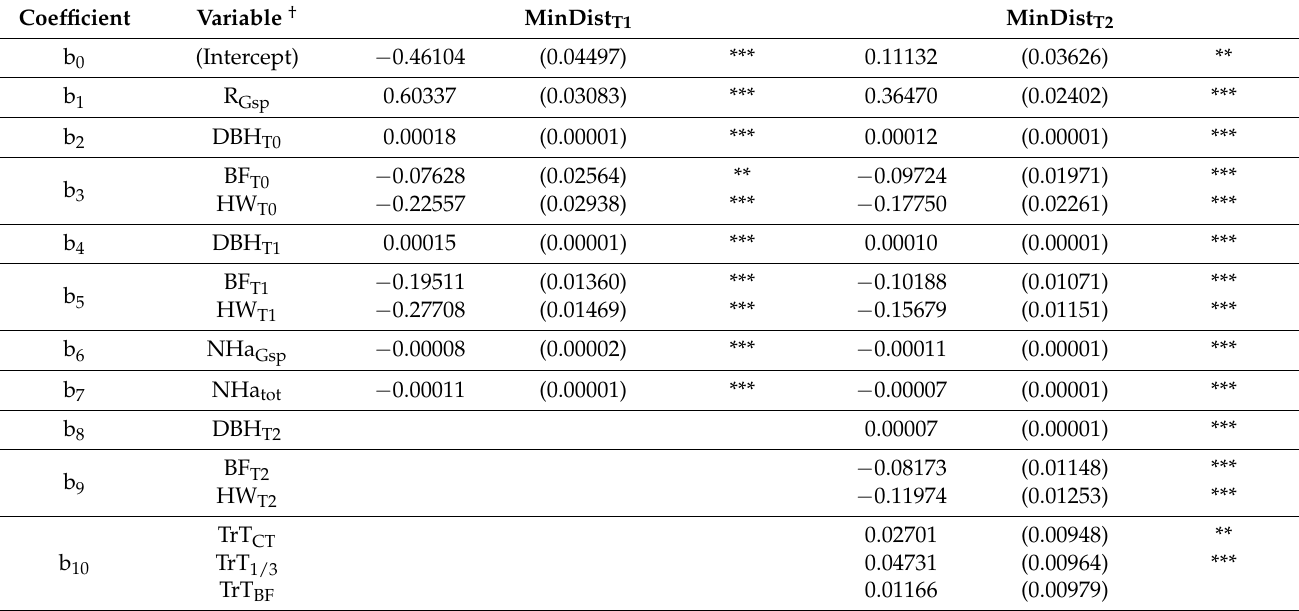
Table 4. Parameters estimations (standard error) of the models selected to predict the distance of the two nearest competitors (Equations (5) and (6)) (* ( p < 0.05); ** ( p < 0.001); *** ( p <